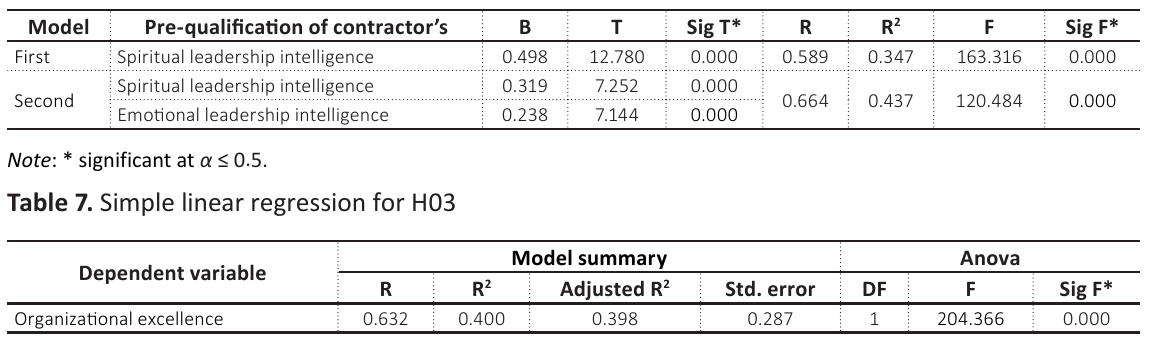
Table 6. Stepwise regression for H02